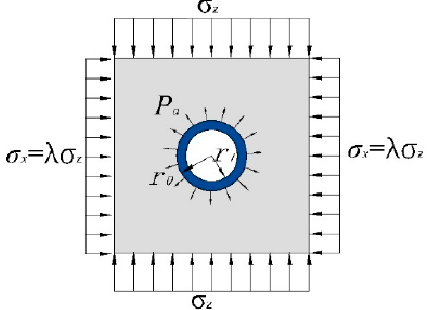
Figure 4. Stress state of surrounding rock of roadway with support.